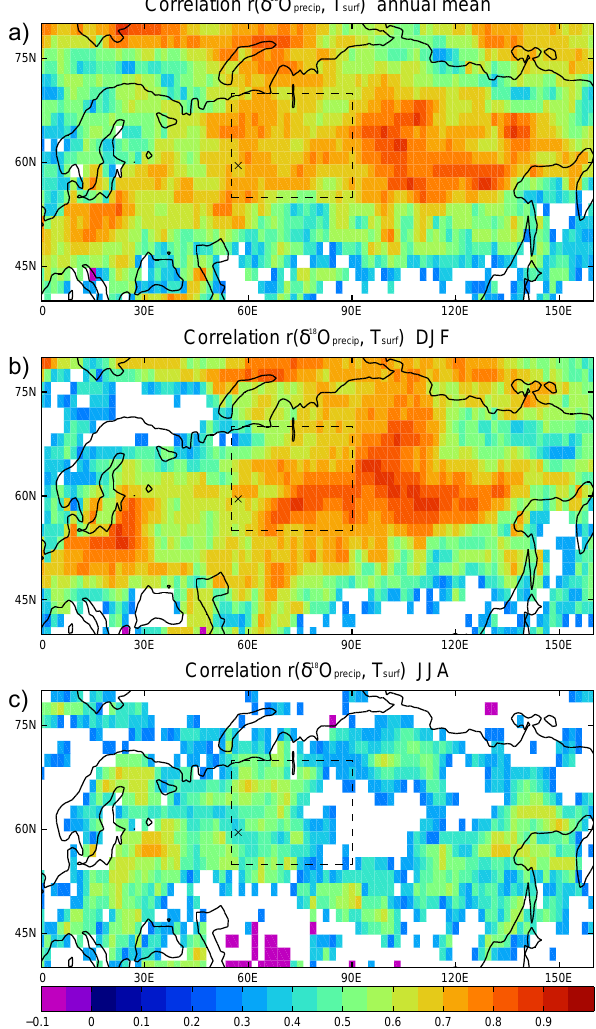
Figure 7. Temporal correlation between simulated values of δ 18 O in precipitation and surface temperatures for the period 1960–2010. Correlation coefficients are calculated for (a) annual mean, (b) win- ter (DJF), and (c) summer (JJA) values of temperature and δ 18 O. Statistically insignificant areas (where p ≥ 0.05 applying a t test) are